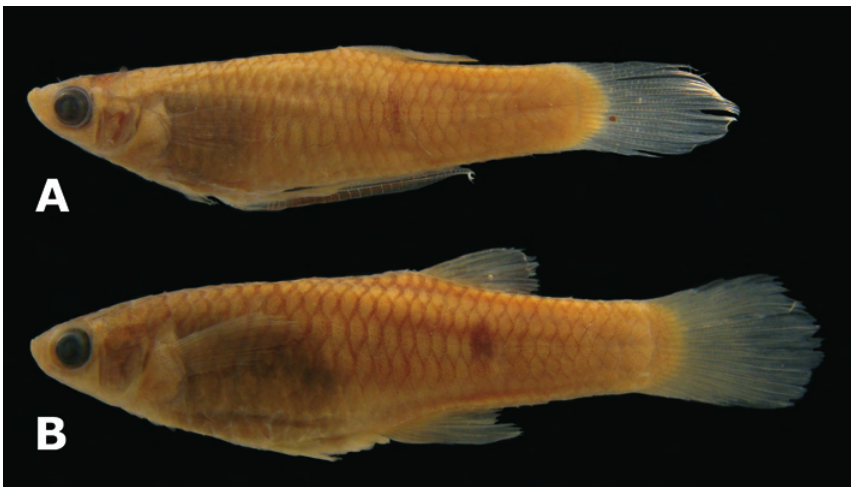
Fig. 27. Phalloceros harpagos . (A) Holotype, male, 26.9 mm SL, MNRJ 23610, rio São Francisco, tributary to rio